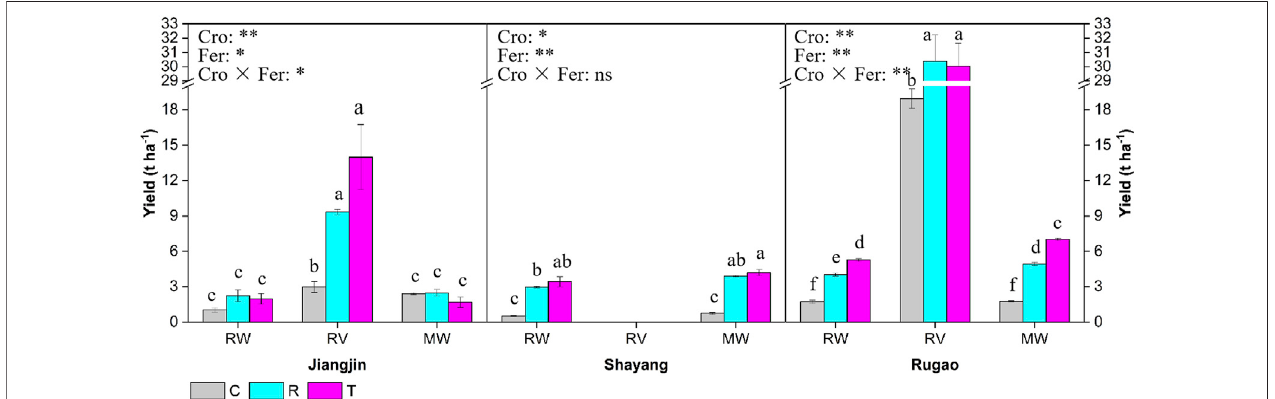
FIGURE 2 | Wheat and vegetable yields at Jiangjin, Shayang, and Rugao. Note: RW = Rice – Wheat rotation. RV = Rice – Vegetable rotation. MW = Maize – Wheat rotation.Errorbarspresentthestandarderrorofthemeasurementsfromthreereplicates.C=noNfertilizerinput.R=reducedfertilizerinput.T=traditionalfertilizerinput. Differentsmalllettersabovethebarsdenotesigni fi canceatthe5%level.Cro=cropsystem.Fer=fertilization.Cro×Fer=theinteractionsofcroprotationandfertilization. ns, * and ** mean no signi fi cance, p < 0.05 and p <